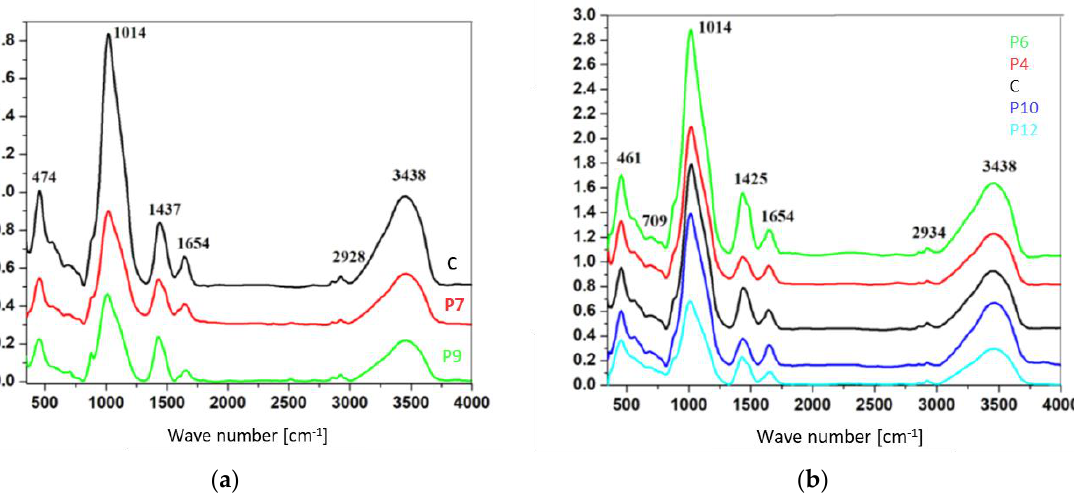
Figure 8. FTIR spectra of geopolymer pastes made with: ( a ) 10% and 50% fly ash substitution with marble dust; ( b ) 10% and 50% fly ash substitution with blast furnace